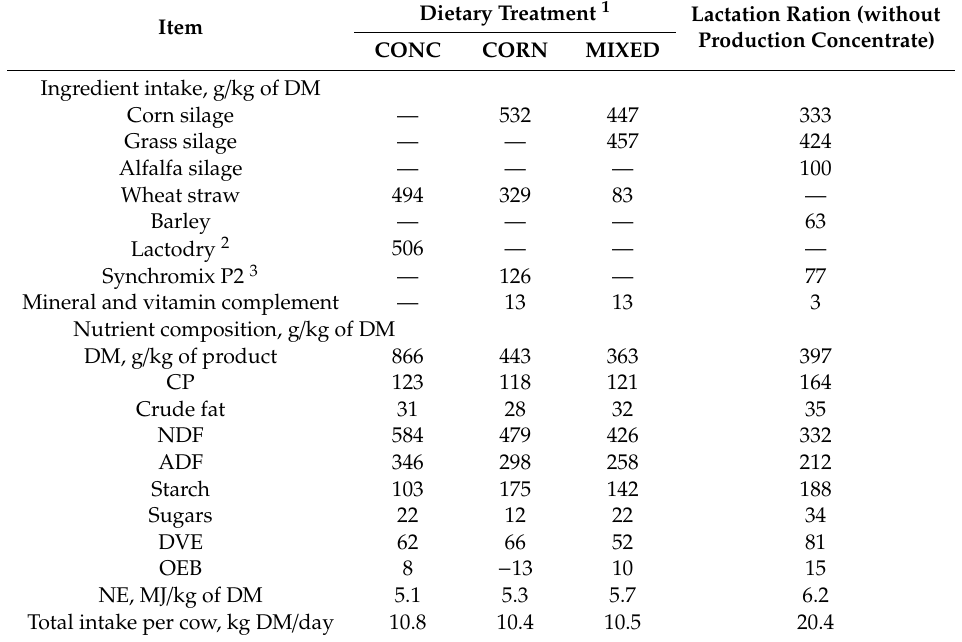
Table 1. Average ingredient and nutrient composition of the diets o ff ered during the dry period and the lactation. Dietary Treatment 1 Lactation Ration Item